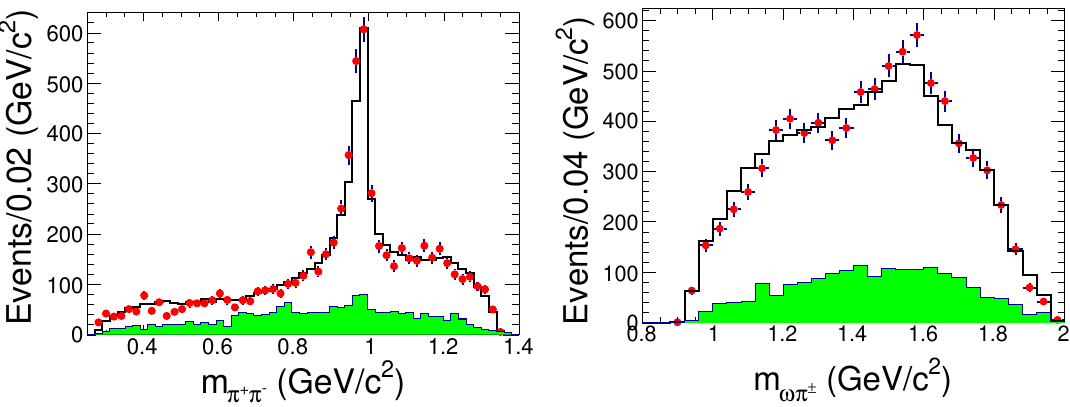
Figure 5 . Projections of the fit results for mass spectra m Dots with error bars are the data, histograms are the total fit results, and shaded histograms (green) are the background estimated by the ω mass sideband.